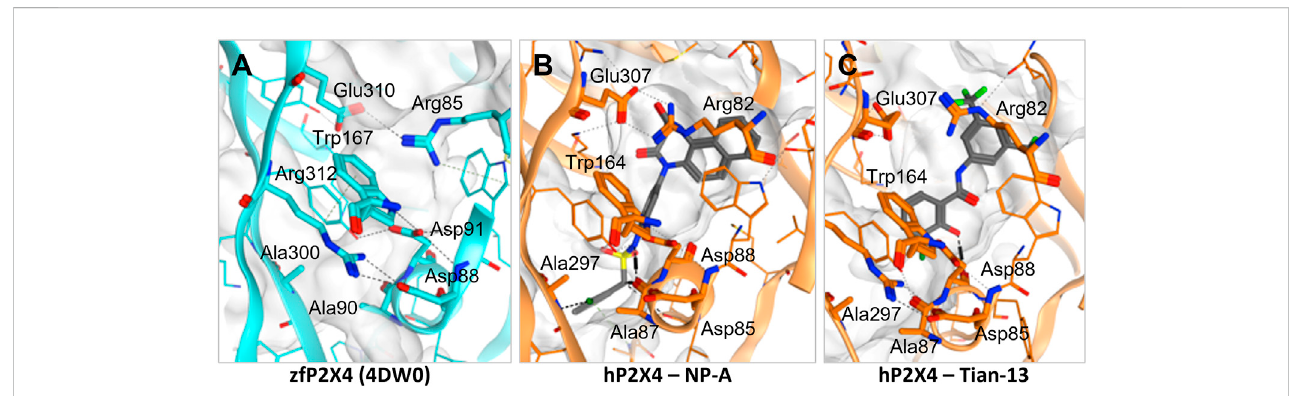
FIGURE 4 Disruption of the inter-residue protein network by P2X4 antagonists. (A) . Crystal structure of zebra fi sh P2X4 (4DW0) with key residues involved in receptor structural stability and activation (in thick lines). (B – C) . Induced- fi t docking of NP-A (B) and Tian-13 (C) into a model of human P2X4. Dashed lines indicate polar